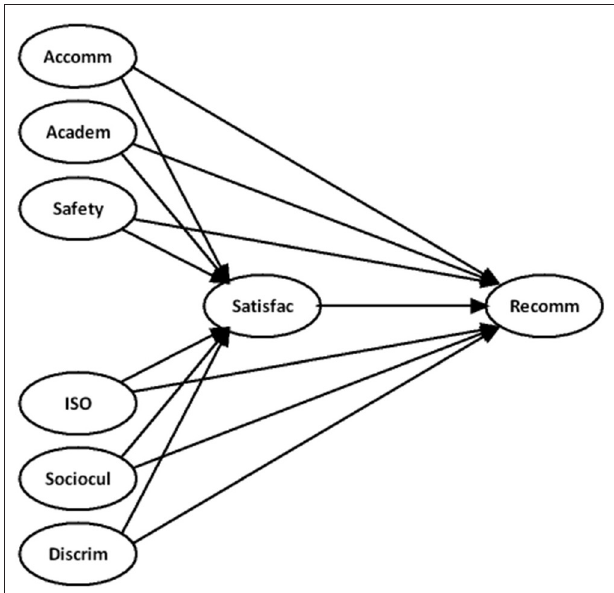
FIGURE 1 | Hypothesized